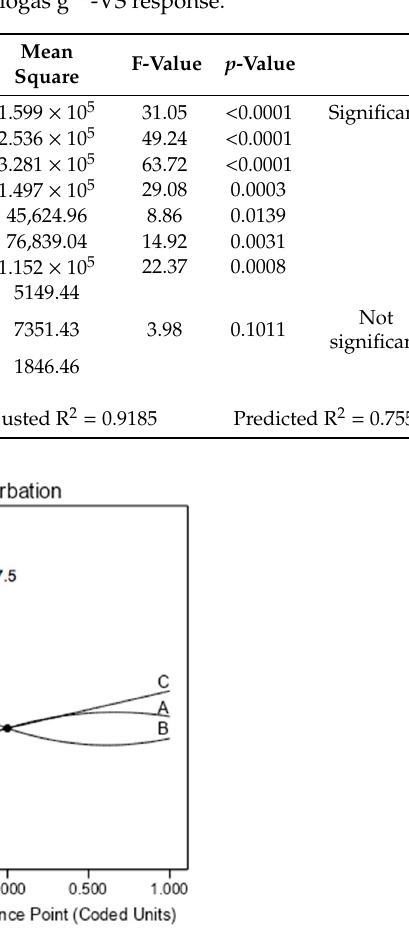
Figure 6. Perturbation plot shows the effect of all factors on the biogas g –1 -VS volume.